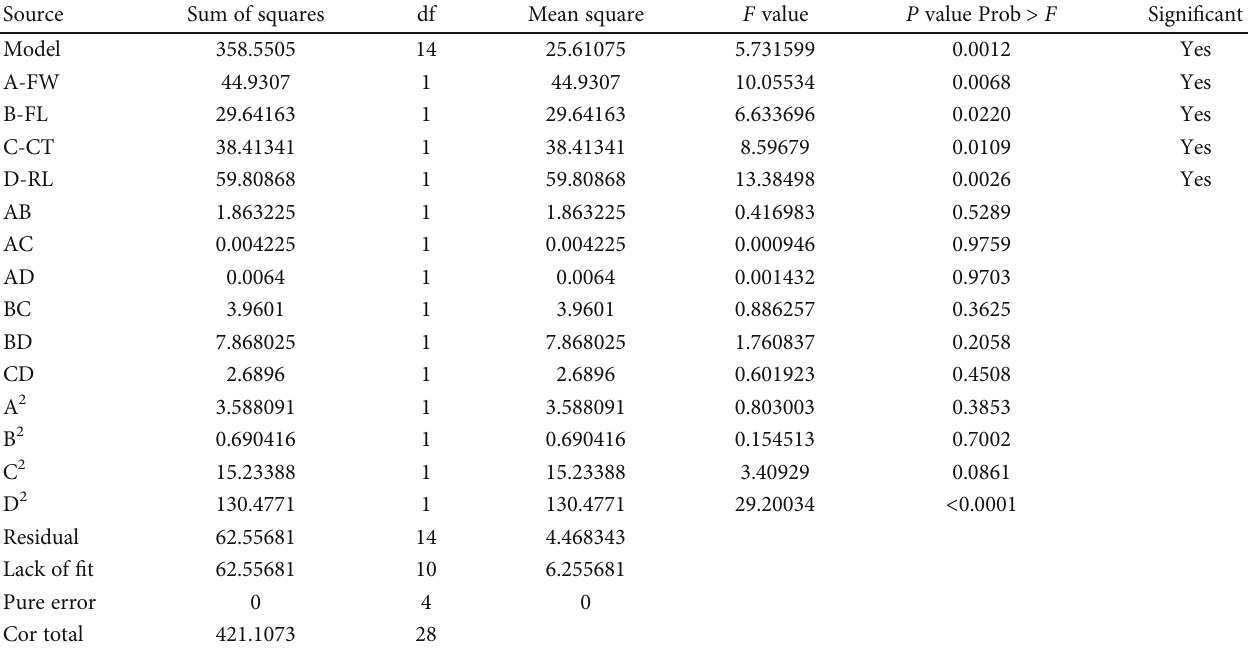
Table 4: Statistical approach to select the RSM model for frost heaving force.